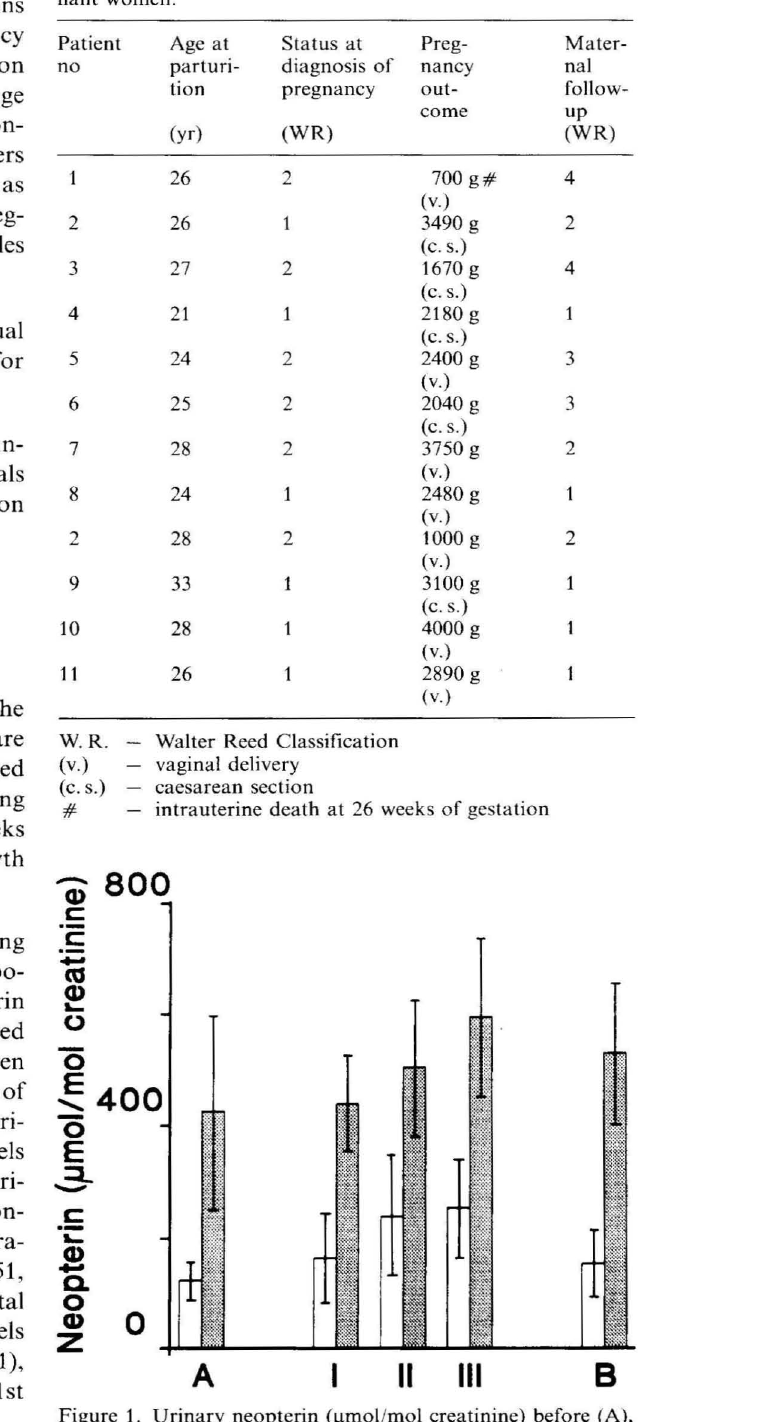
Figure 1. Urinary neopterin (Ilmol/mol creatinine) before (A), during (trimenons I, II and III) and after (8) pregnancy of HIV-l seropositive women compared to normal pregnant women. Mean ± S. D . is shown for HIV-l seropositive (dotted bars; mean values of each individual were used for calculation of means shown in the Figure) and HIY-l seronegative pregnan cies (plain bars; values shown stem from an earlier study on neopterin in normal pregnant women; Ref.